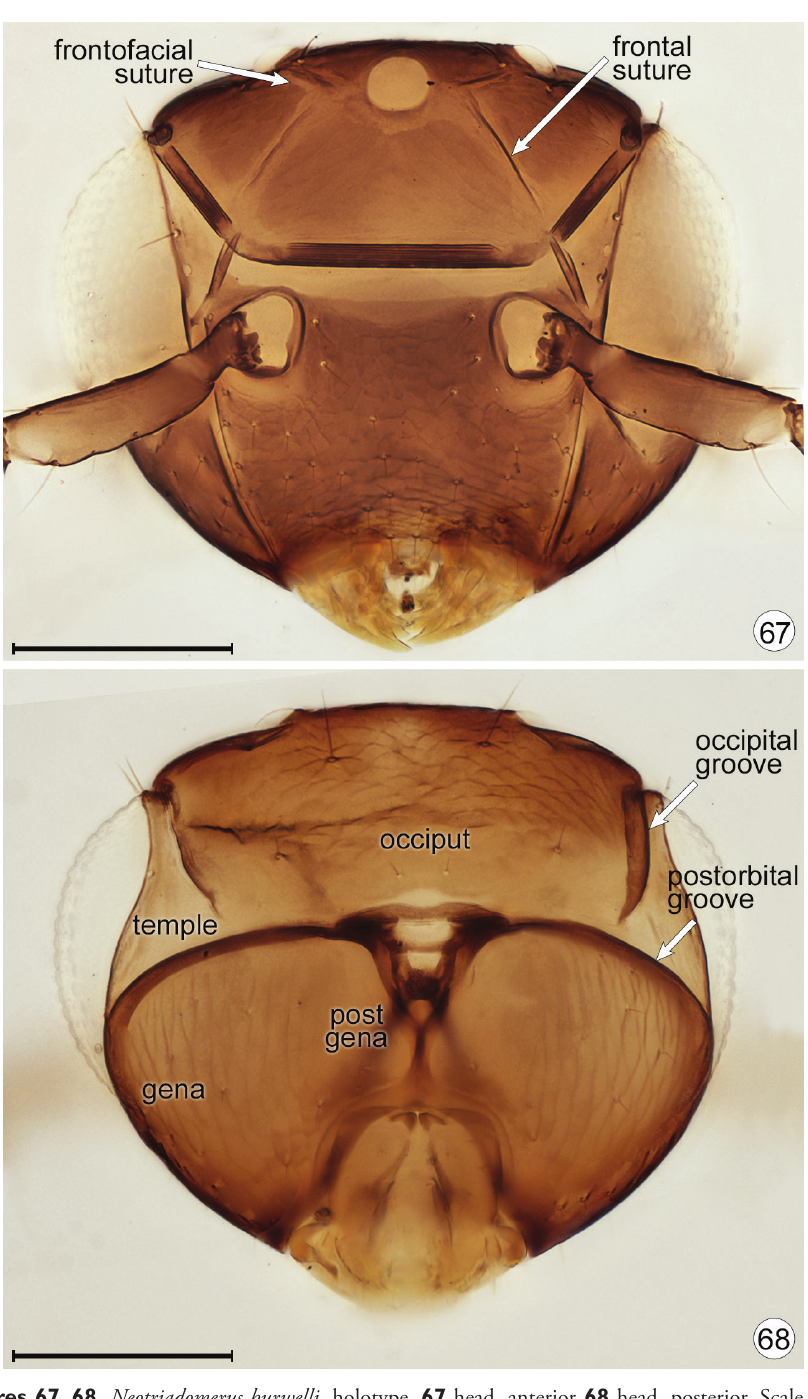
Figures 67, 68. Neotriadomerus burwelli , holotype. 67 head, anterior 68 head, posterior. Scale bar = 100